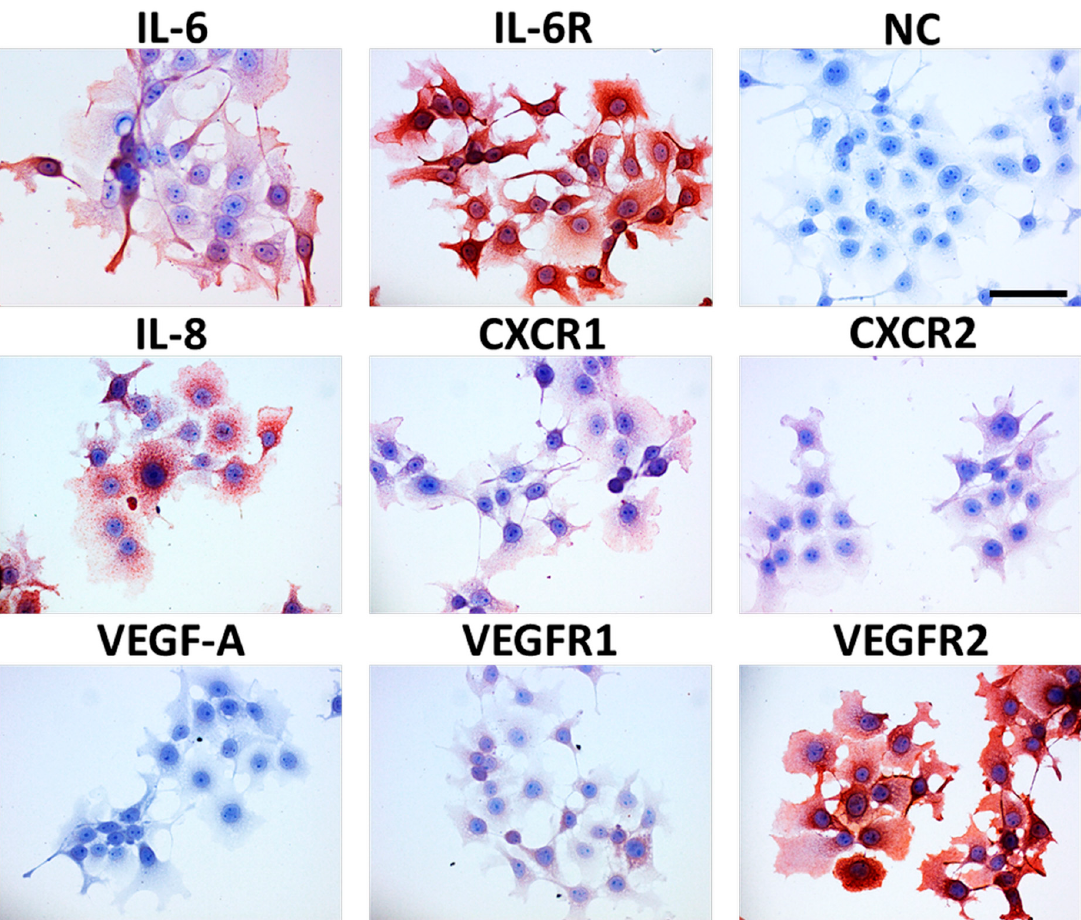
Figure 6. This figure shows HNSCC cell line FaDu from hypopharynx cancer with detected IL-6, IL- 8 and VEGF-A and their receptors. NC is a negative control. Nuclei are counterstained with haematoxylin; the bar represents 50 μ m. Immunocytochemistry performed in the authors´